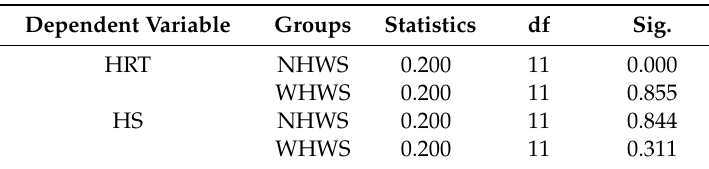
Table 3. Tests of normality.